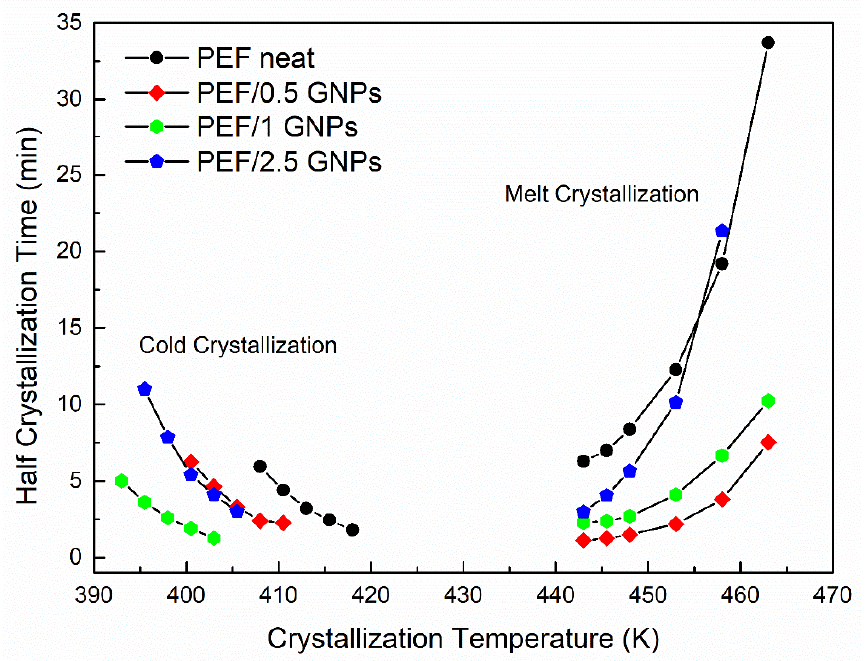
Figure 4. Half crystallization time vs. selected crystallization temperatures of the neat PEF and PEF/GNPs.